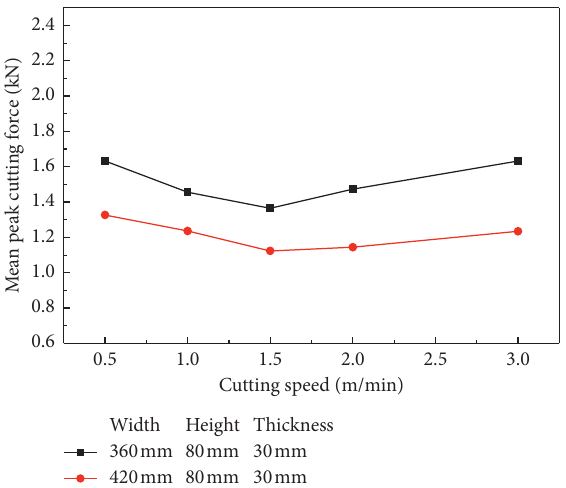
Figure 18: The variation of mean peak force with cutting